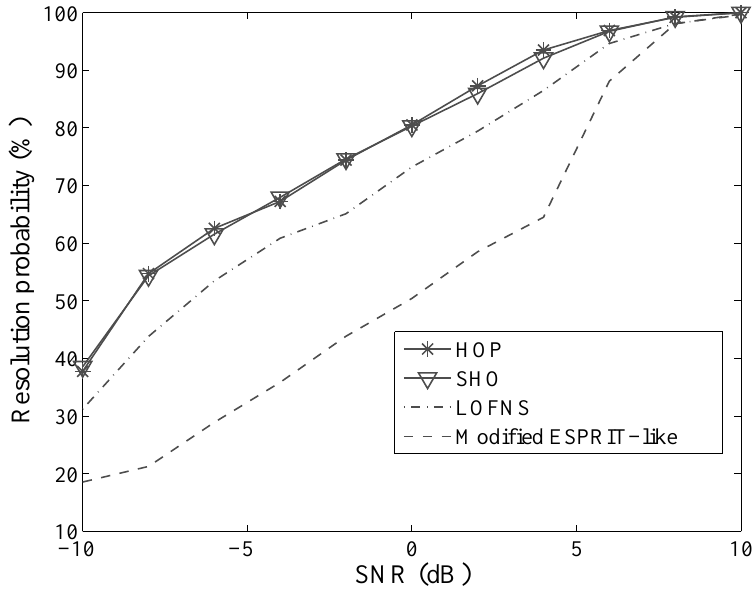
Figure 3. Resolution probability versus